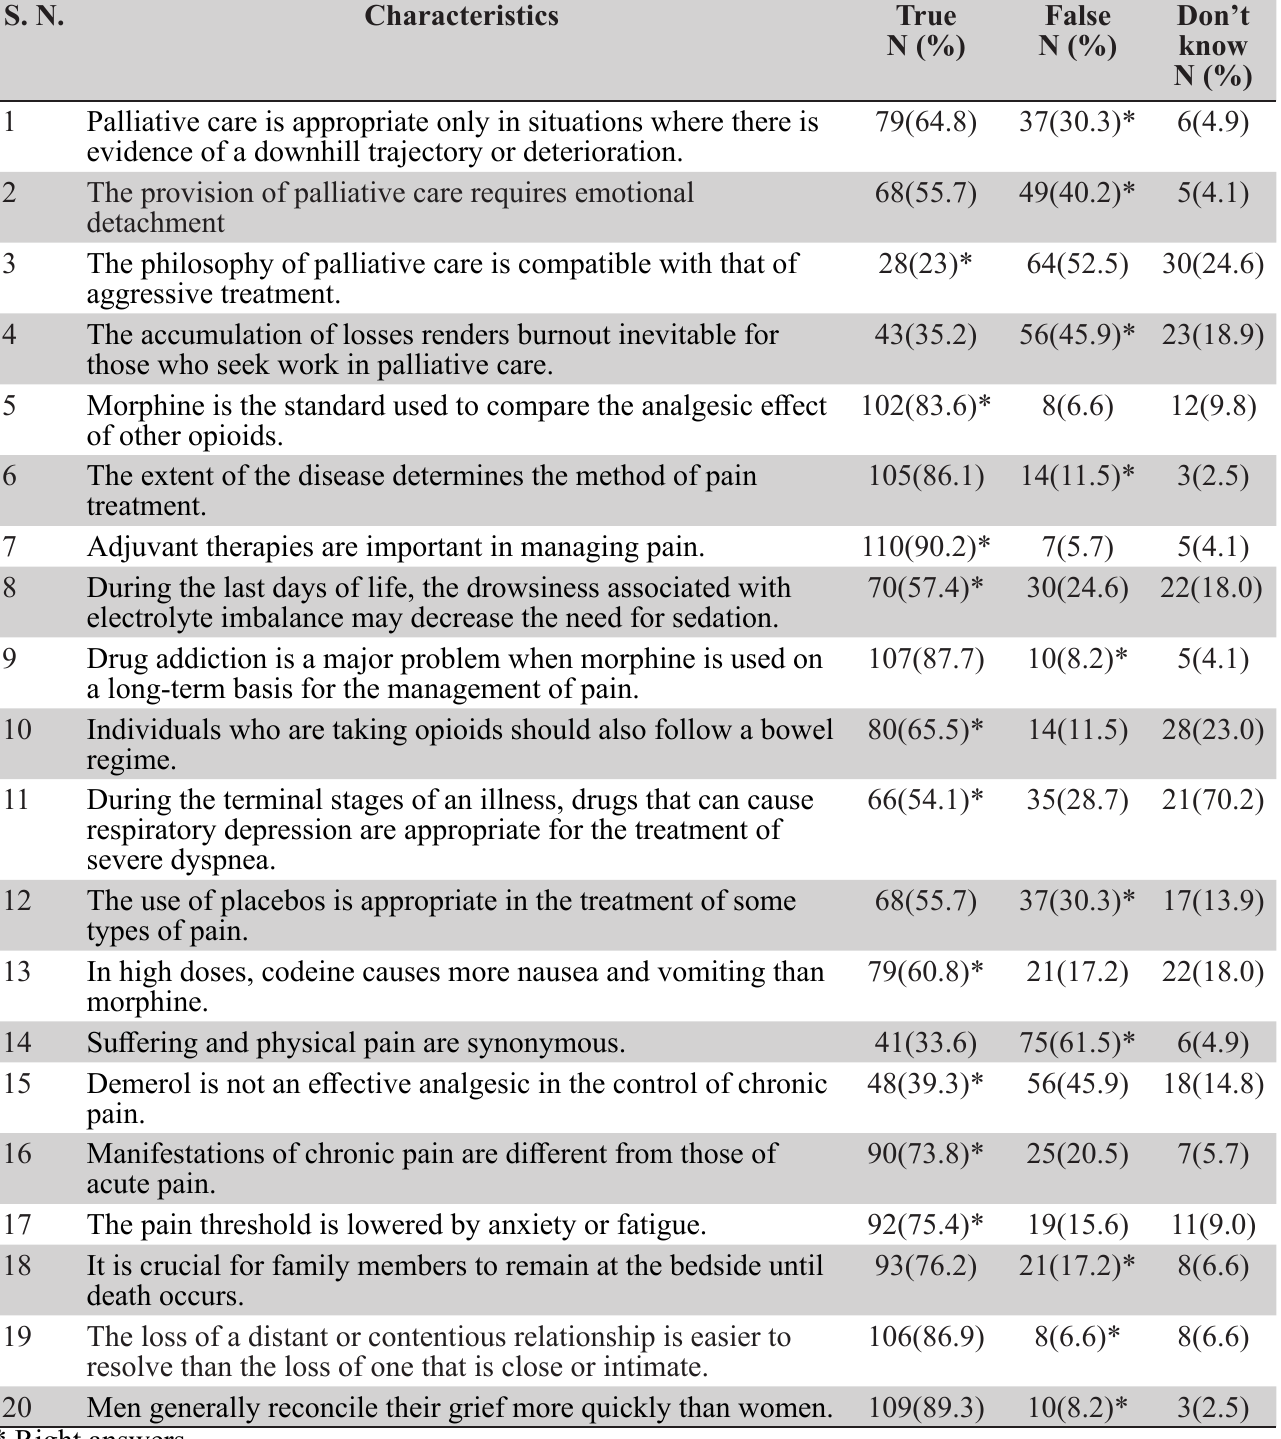
Table 1. Knowledge on palliative care of participants measured by PCQN (n=122). S.